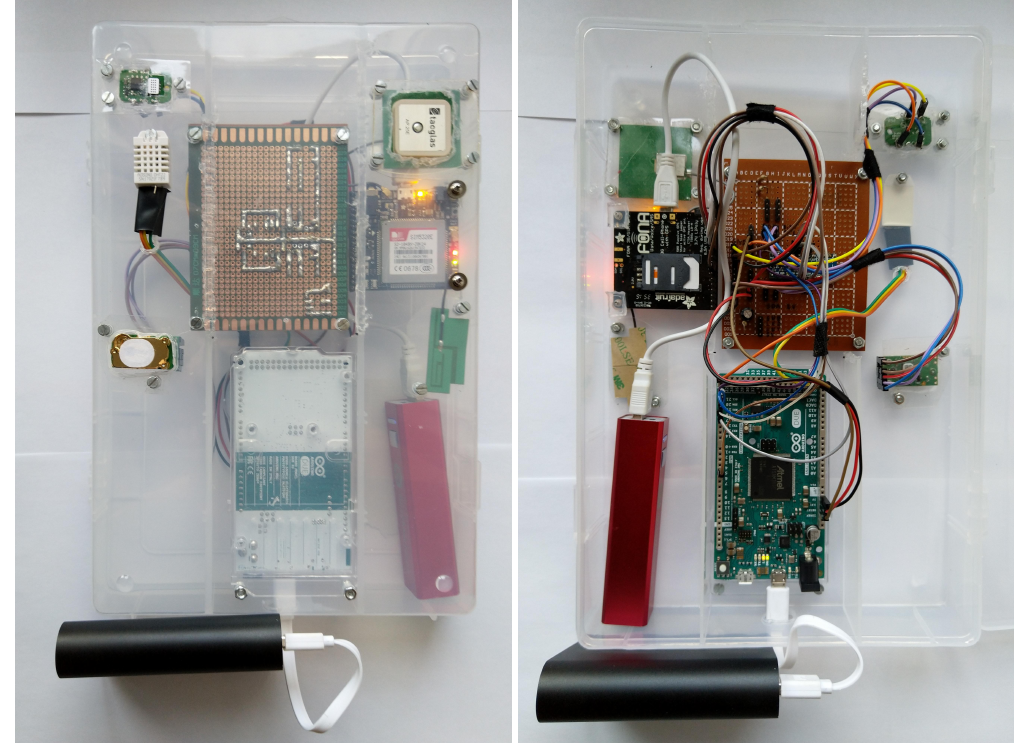
Figure 4. The resulting proof-of-concept multi-sensor